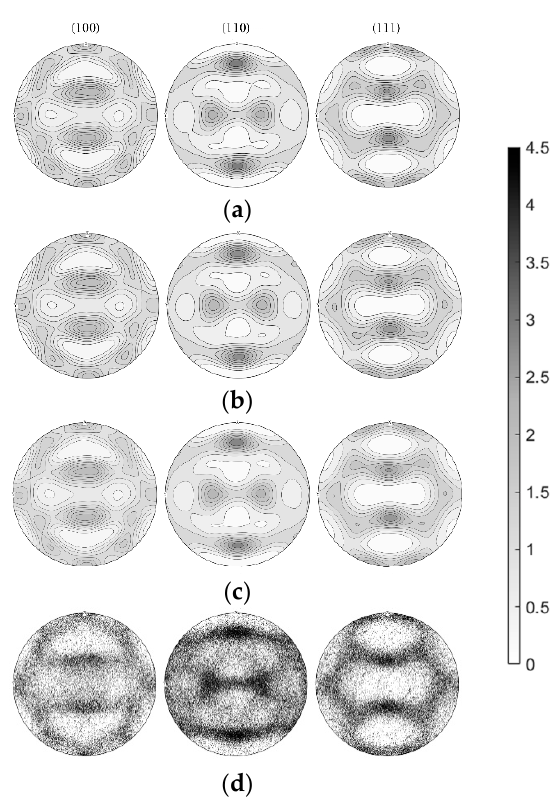
Figure 3. ( a ) Orientation distribution function (ODF) calculated from orientation clusters, ( b ) ODF calculated from individual orientations, and ( c ) the final averaged ODF compared to ( d ) the stereographic projections of the individual orientations. Table 2. Ideal orientations of analyzed texture components and corresponding Euler angles (Bunge convention)